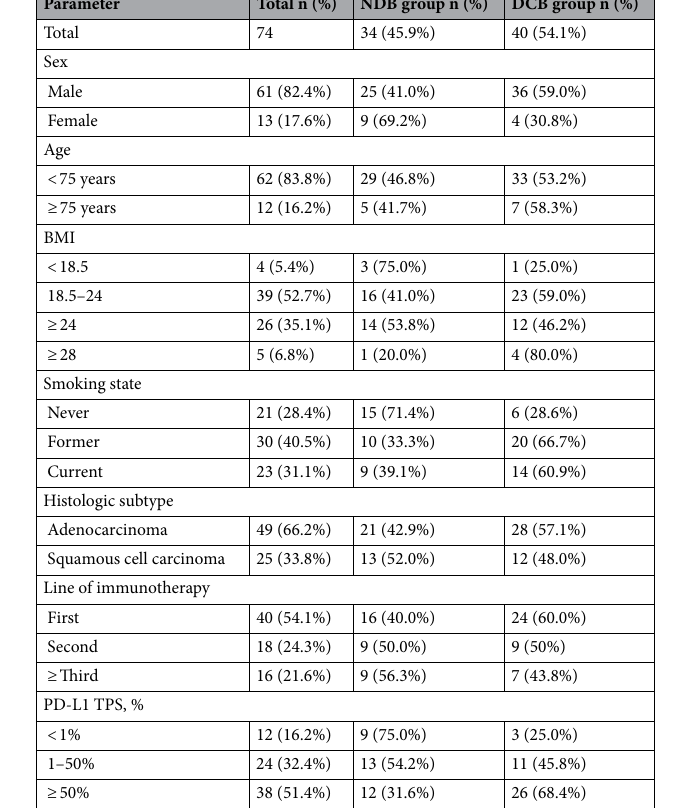
Table 1. Study population